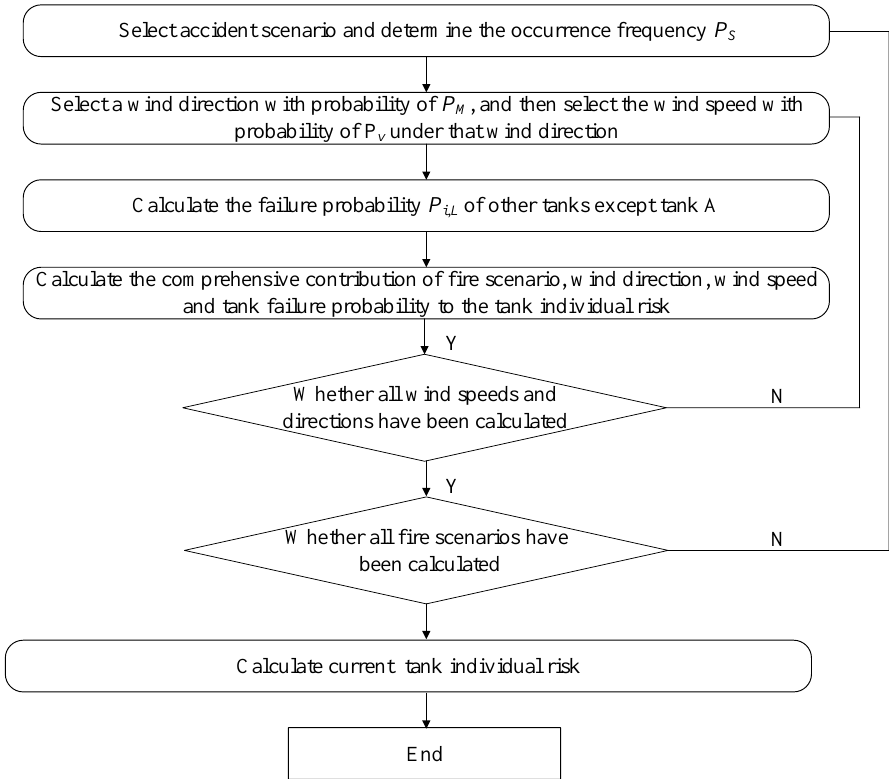
Figure 2. Tank failure risk calculation program.